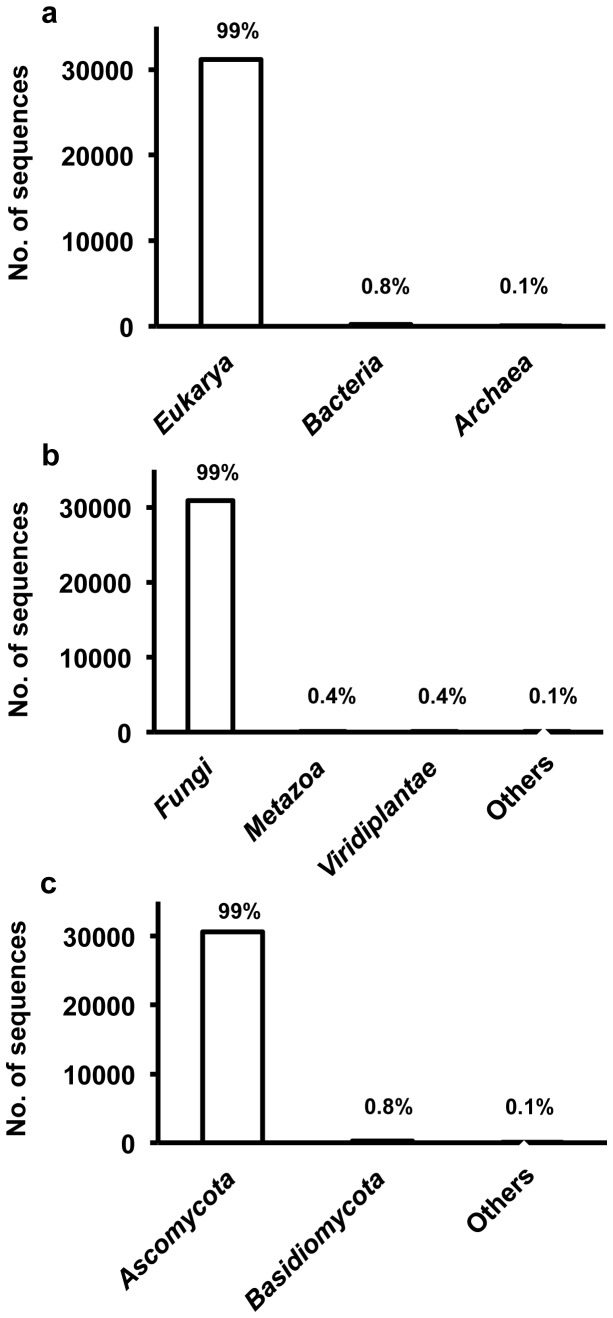
Taxonomic classifications of the sequenced cDNAs based on BLAST analysis.Sequences that did not return any significant hits (usually E values greater than 10−8) were classified as unknown. The figure indicates the Domain (a), Kingdom (b) and Phylum levels (c).